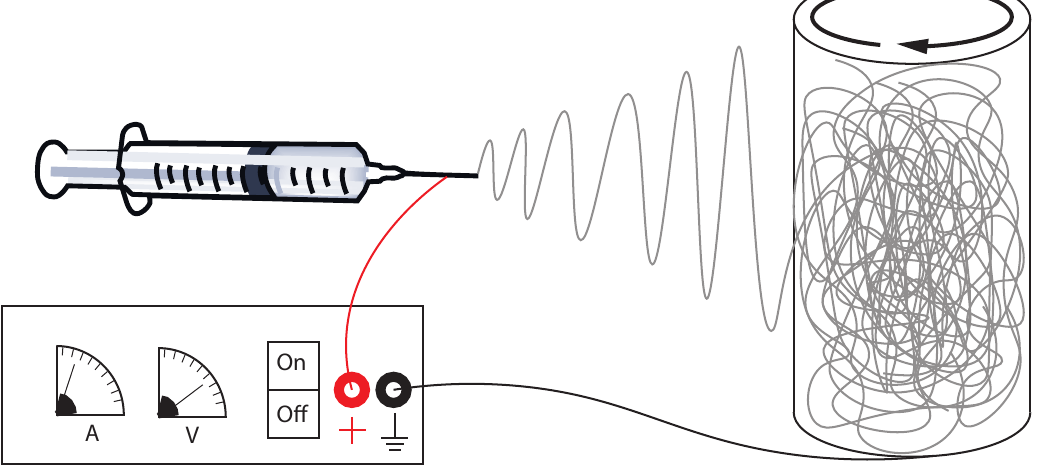
Figure 1. Schematic of the electrospinning set-up used to prepare fibrous PU/CNC mats. A high-voltage power supply is used to apply a voltage of about 10 kV between a syringe that contains a PU/CNC solution in DMF and a cylindrical aluminum collector. Rotation of the collector facilitates production of fibrous mats of homogeneous